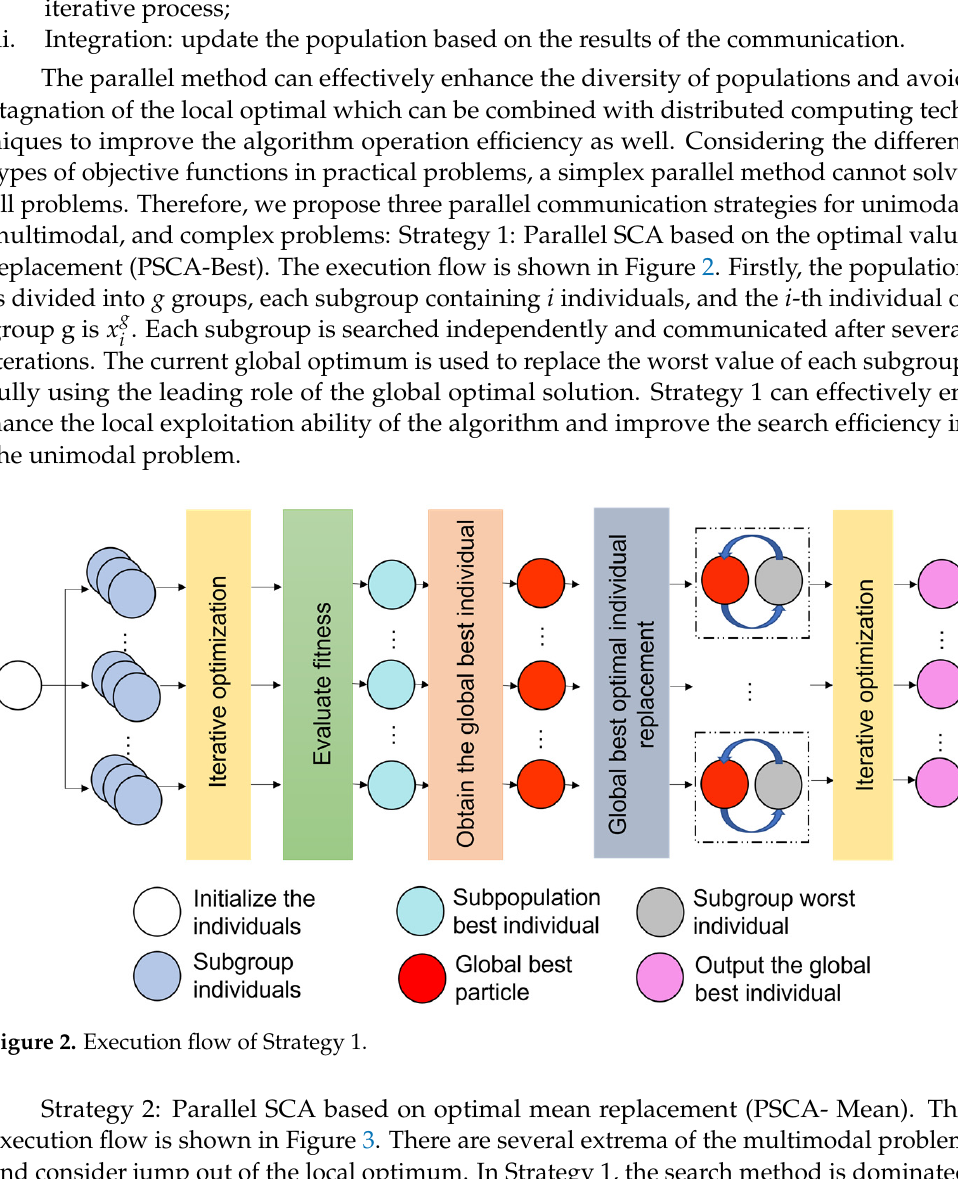
Figure 1. Working principle diagram of the PCNN.